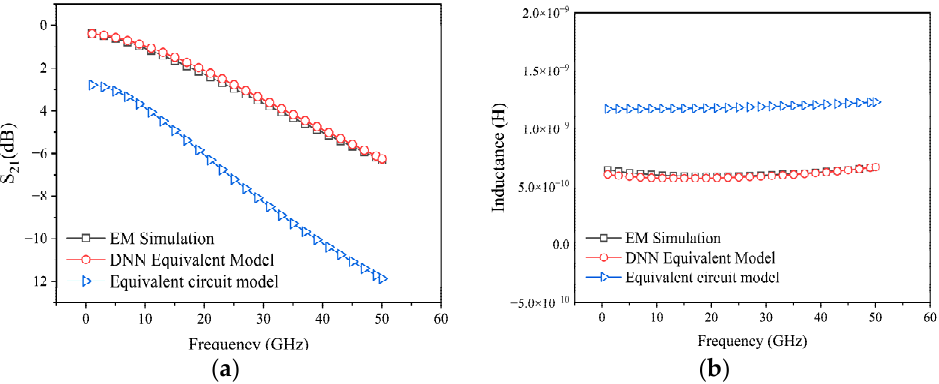
Figure 12. S-parameters (S 21 ) and inductance with three layers of DMFs and a metal filling density of 20%; ( a ) shows S-parameters (S 21 ) and ( b ) shows inductance values. Table 5. Comparison of the efficiency of the EM simulation and the method proposed in this paper. Number of Metal Filling Method Layers of DMFs Density